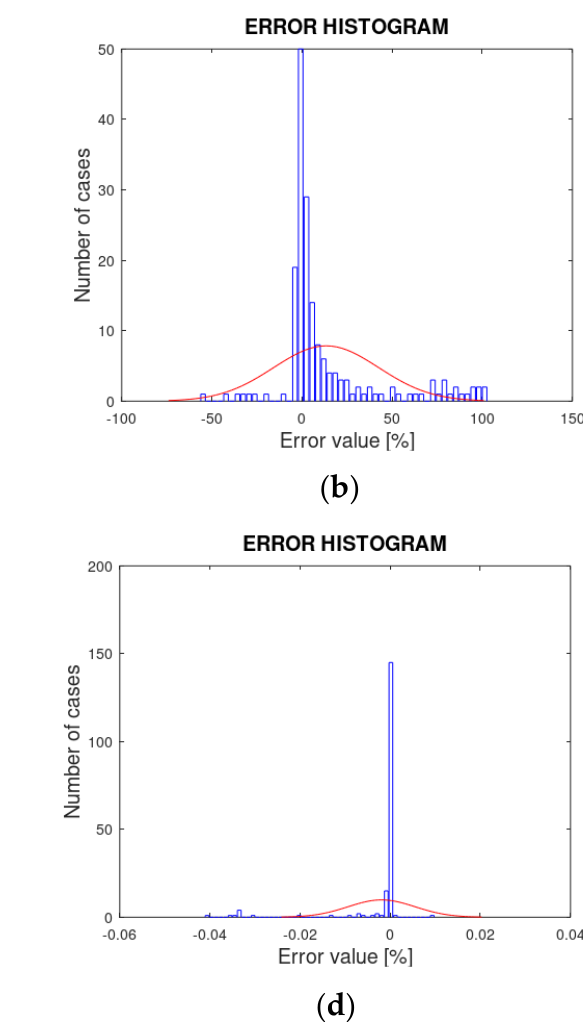
indicators are in the optimal range. Even the largest error value of 0.36% for the RMPSE, as shown in Table 3, is a more than acceptable value.